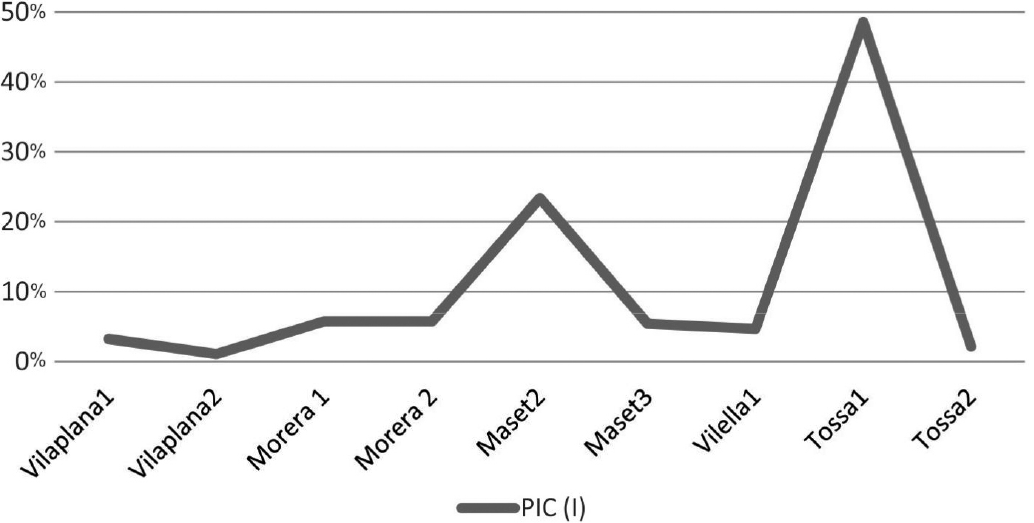
Figure 13. Distribution of the chert varieties identified in the Picamoixons